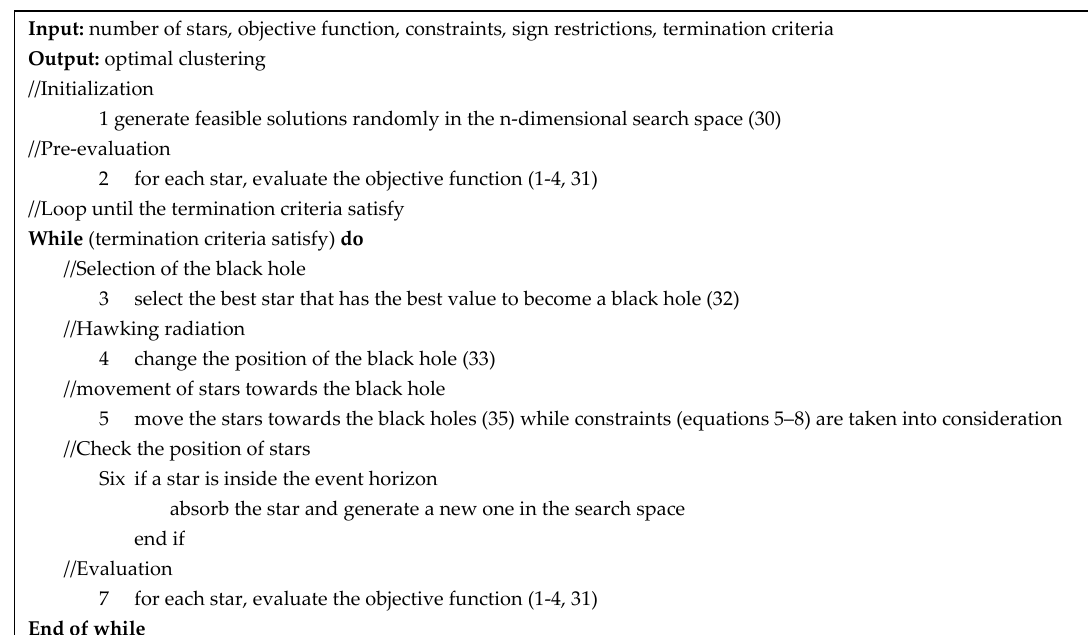
Figure 13. Clustered and sequenced supply-demands in scenario 2.